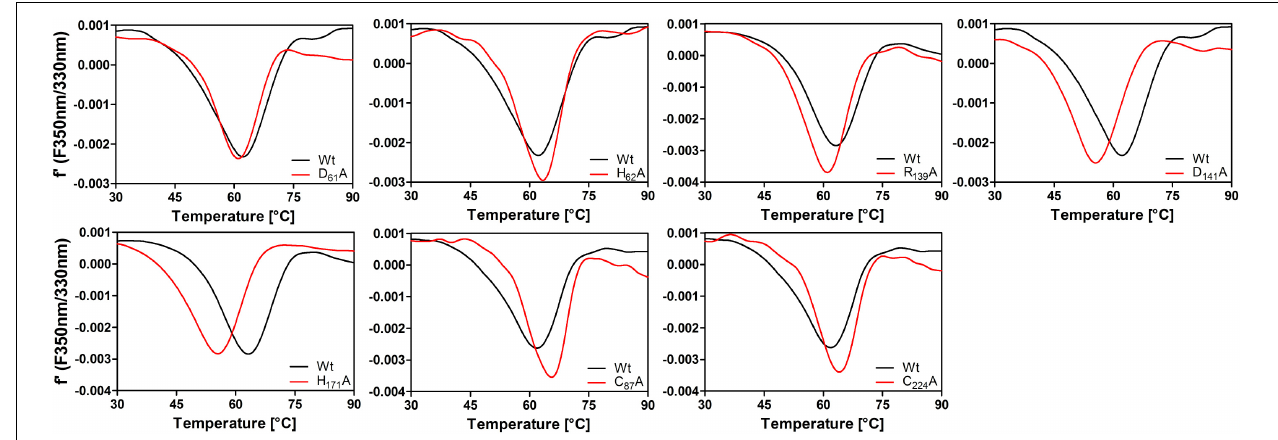
FIGURE 10 | First derivative plots of differential scanning fluorimetry (tryptophane/tyrosine fluorescence) of Ac PDO variants (1 mg/ml) measured in 100 mM Tris buffer, pH 8.0, at a heating rate of 1 K/min and comparison with wild